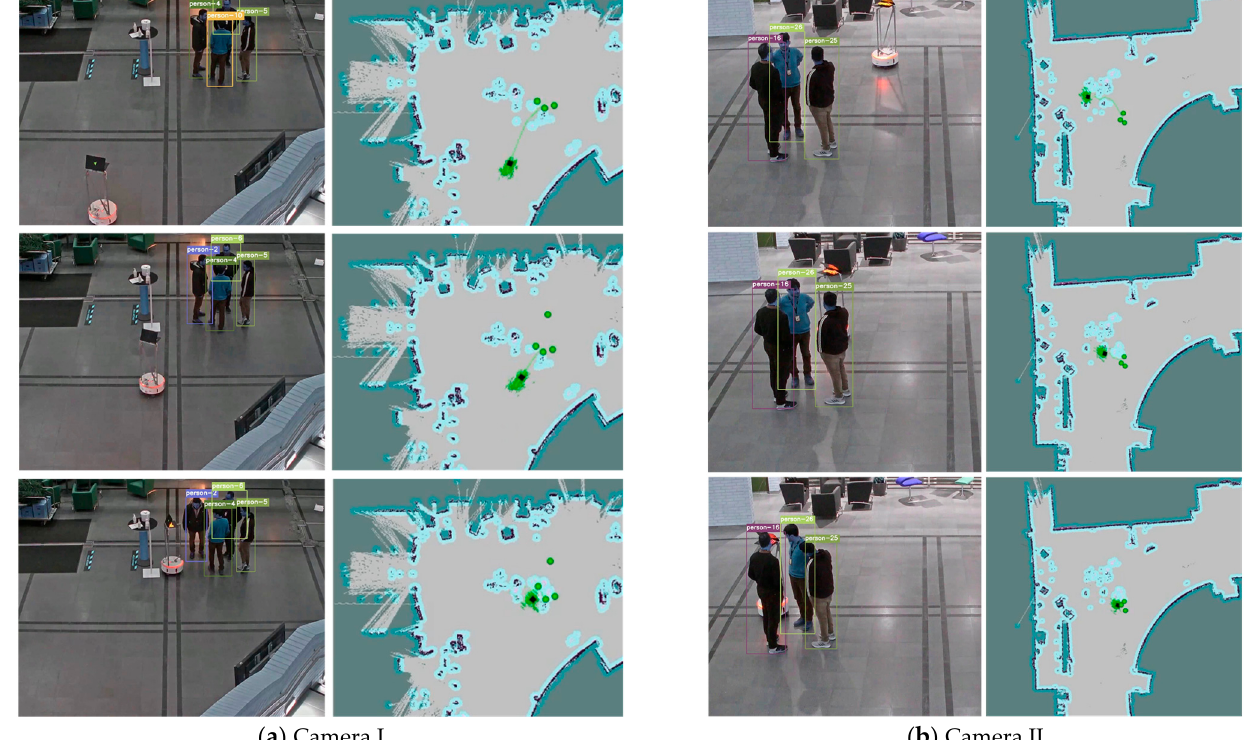
Figure 9. Re-identification of non-compliant group and enforcement of physical distancing constraints through robot. ( a ) A non-compliant group consisted of four persons detected by Camera I. ( b ) Same group re-identified by Camera II with re-identification score, while again violating the physical distancing constraints.